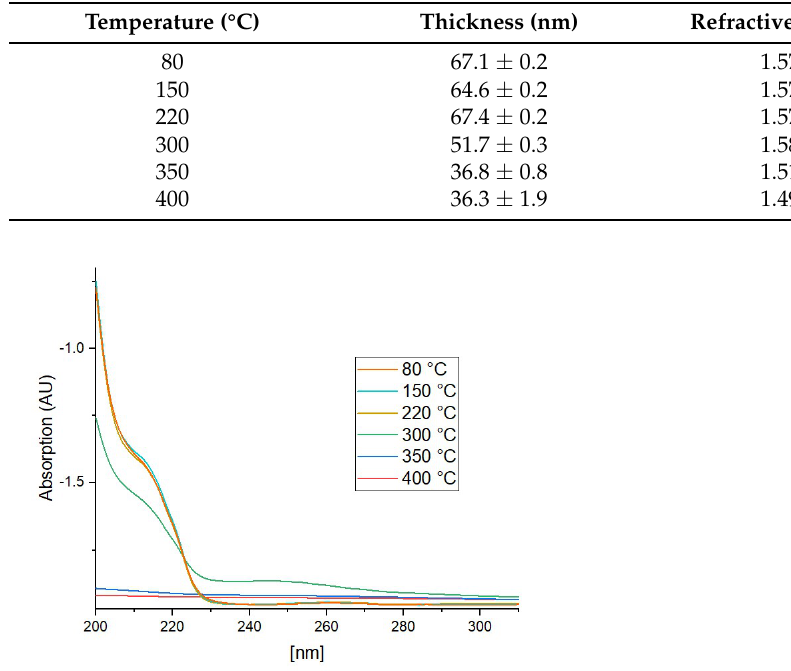
Figure 6. Temperature dependence of absorption of 0.5% (wt) PSAN thin films.